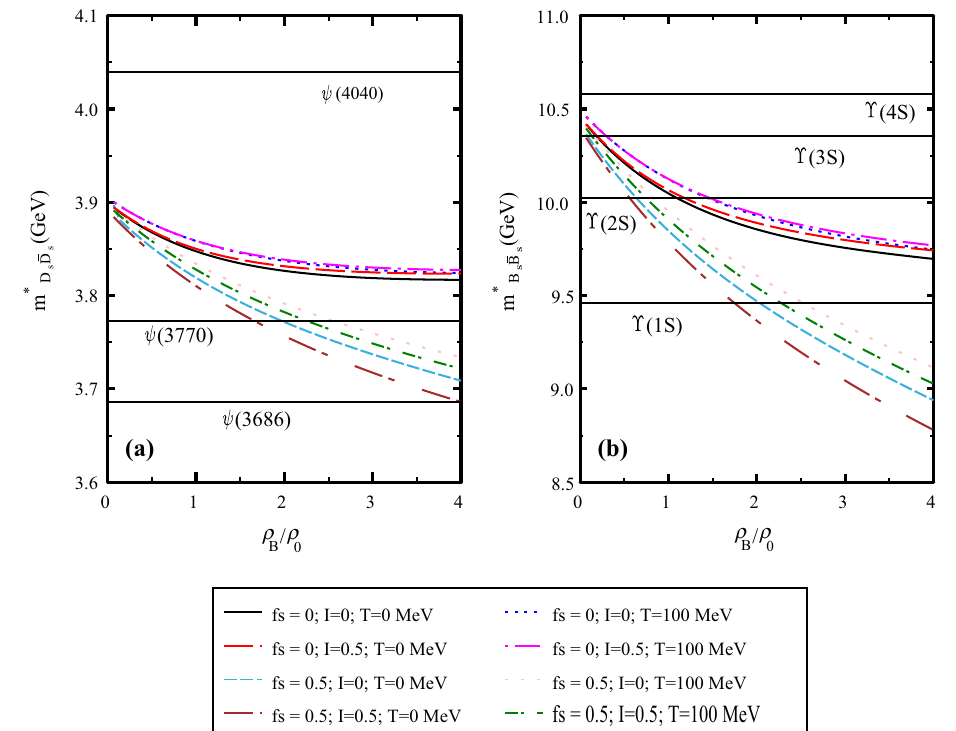
Fig. 5 We compare the masses of the D s ¯ D s and B s ¯ B s pairs, against charmonium (subplot a ) and bottomonium (subplot b ) states, respectively, for different medium situations, as described in the